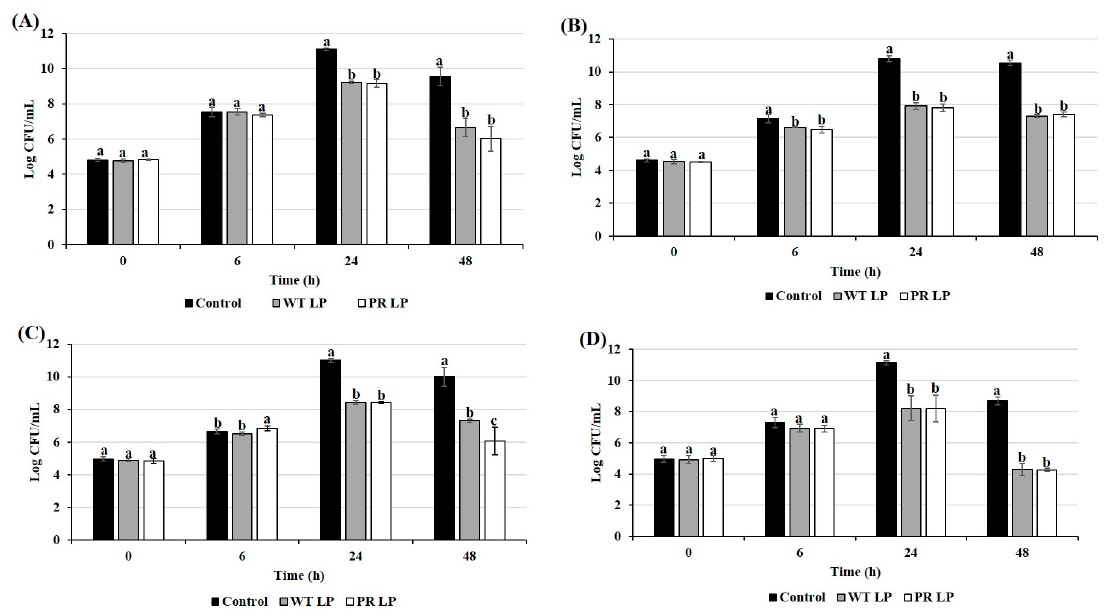
Figure 3. Growth inhibitory effects of cell-free cultural supernatants (CFCSs) from wild-type LP and LP +PR strains on S. Typhimurium ( A ), EHEC ( B ), S. aureus ( C ), and L. monocytogenes ( D ) at 0, 6, 24, and 48 h. Error bars indicate standard deviation from 6 parallel trials. Different letters (a–c) at each time point indicate the significant growth reduction when compared to control at P < 0.05.